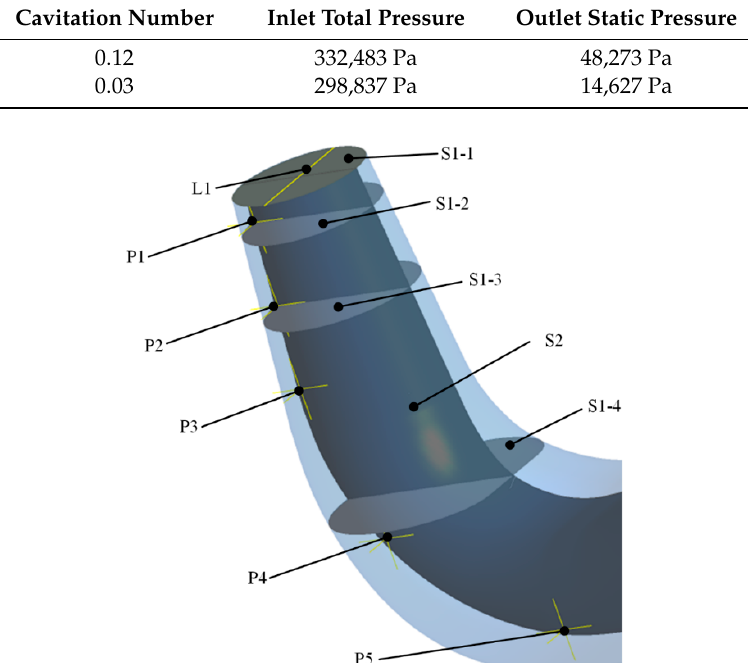
Table 3. Boundary conditions at di ff erent cavitation numbers.